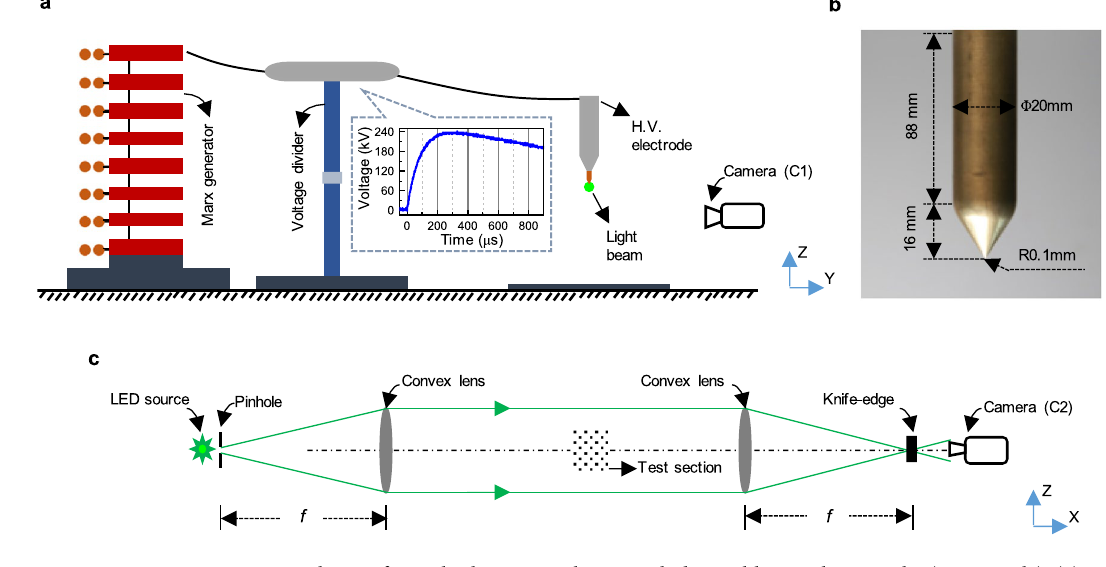
Figure 5. Experimental setup for multiple streamer bursts including Schlieren photography (not to scale). ( a ) Schematic of the experimental setup. The high-speed camera (C1) is used to observe the streamer morphology. The green circle at the electrode tip marks the light beam of the Schlieren system. ( b ) Details of the cone-shaped brass electrode. ( c ) Diagram of the Toepler’s lens-type Schlieren imaging system to the second high-speed camera